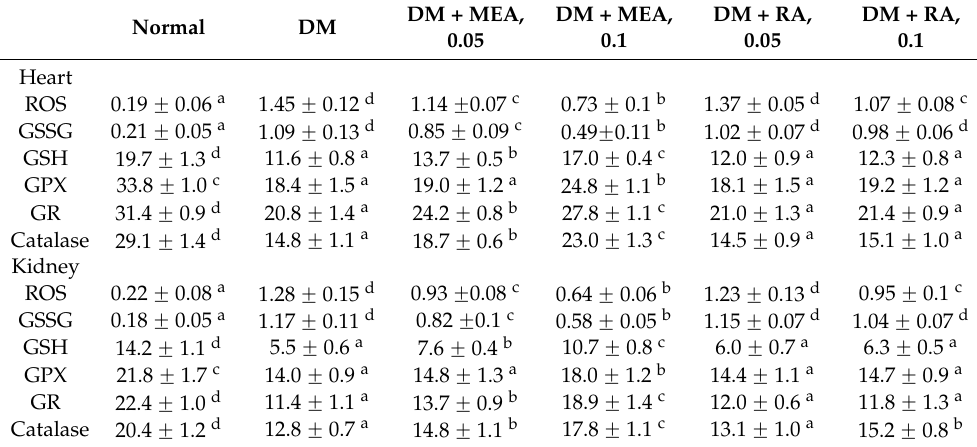
Table 4. Levels of ROS (RFU/mg protein), GSSG (nmol/mg protein), GSH (nmol/mg protein) and activity (U/mg protein) of GPX, GR and catalase in heart and kidney from normal (non-diabetic), diabetic mice consumed normal diet (DM), or 0.05%, 0.1% MEA or RA for six weeks. Data are mean ˘ SD, n = 10.